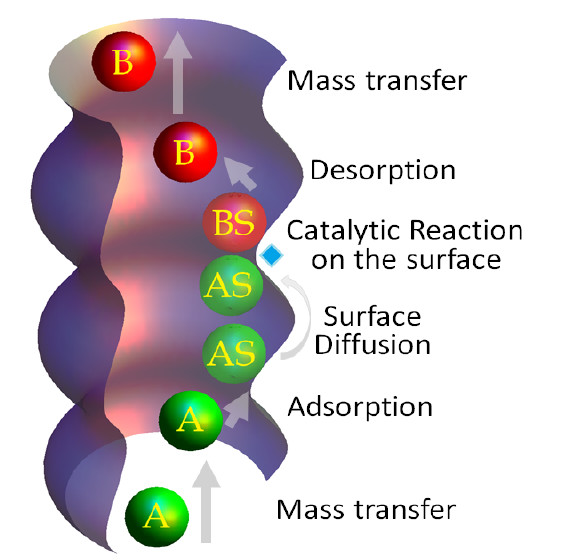
Figure 6. Illustrative image of the different steps of the heterogeneous catalysis inside an irregular